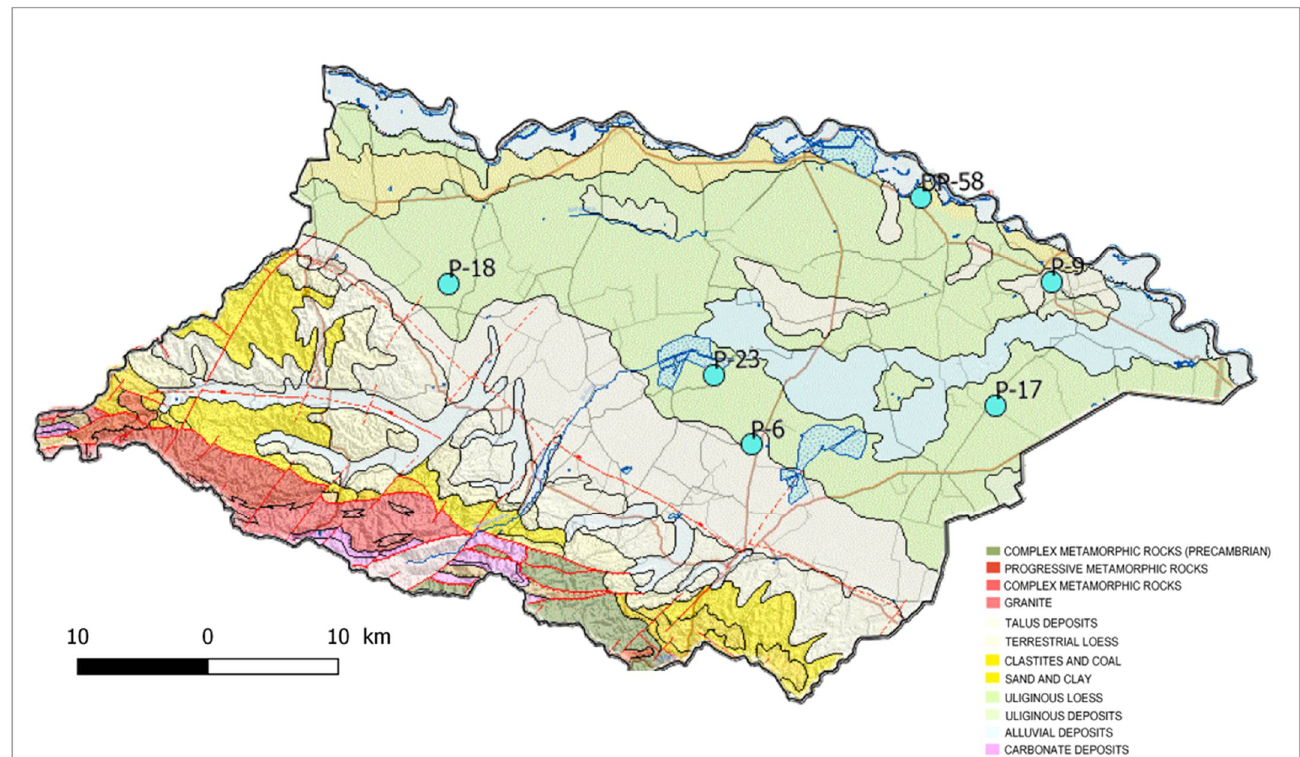
Figure 3. Geological map of the catchment area with designated observation wells, (http://webgis. hgi-cgs.hr/gk300/, accessed on 19 March